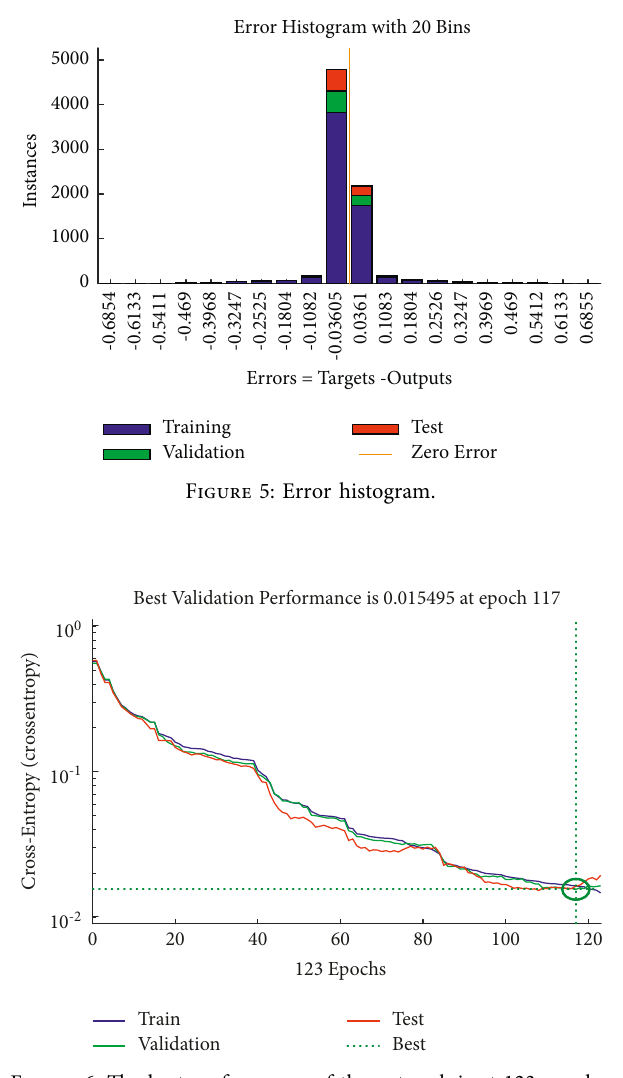
Figure 6: The best performance of the network is at 123 epochs.